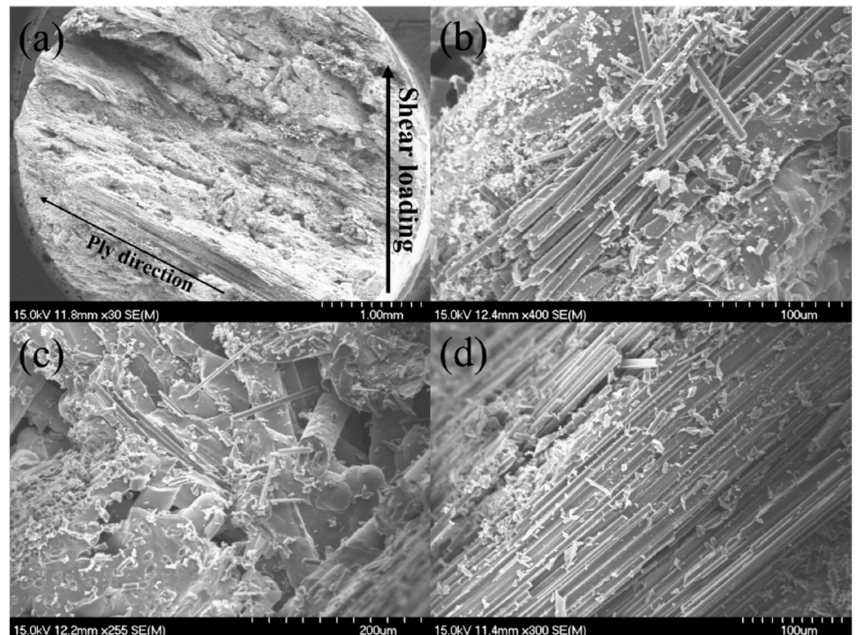
Figure 10. Type III double-shear fracture surface of the 12k T-700 TM MWK–N–C/SiC pin observed under SEM. ( a ) fracture surface; ( b ) fractured fibers; ( c ) fiber pullout; ( d ) fiber fracture and pullout.